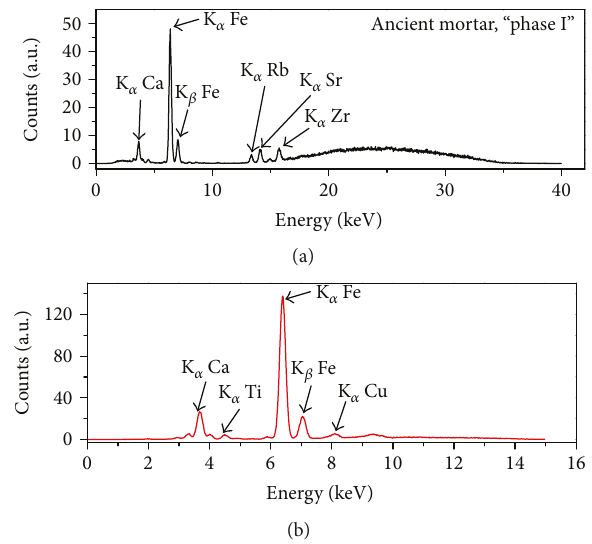
Figure 5: XRF spectra, in the 0 – 40keV range (a) and 0 – 16 keV range (b), of an ancient mortar of “ phase I. ”